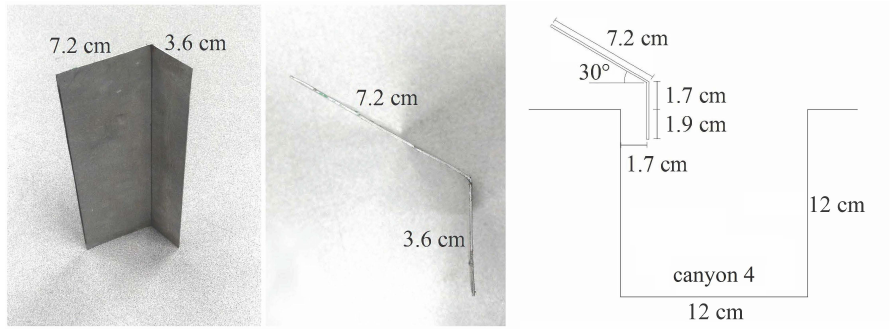
Figure 4. Photos and the dimensions of the wind catcher prototype. Table 1. Summary of cases studied in the water channel. Case (i) represents the reference case with canyons of aspect ratio 1, cases (ii)–(iv) demonstrate the architectural interventions evaluated in this analysis. The middle-canyon profiles of all cases were measured in canyons 3–6 indicated by the dashed line shown in case (i) (not shown in cases (ii)–(iv) for